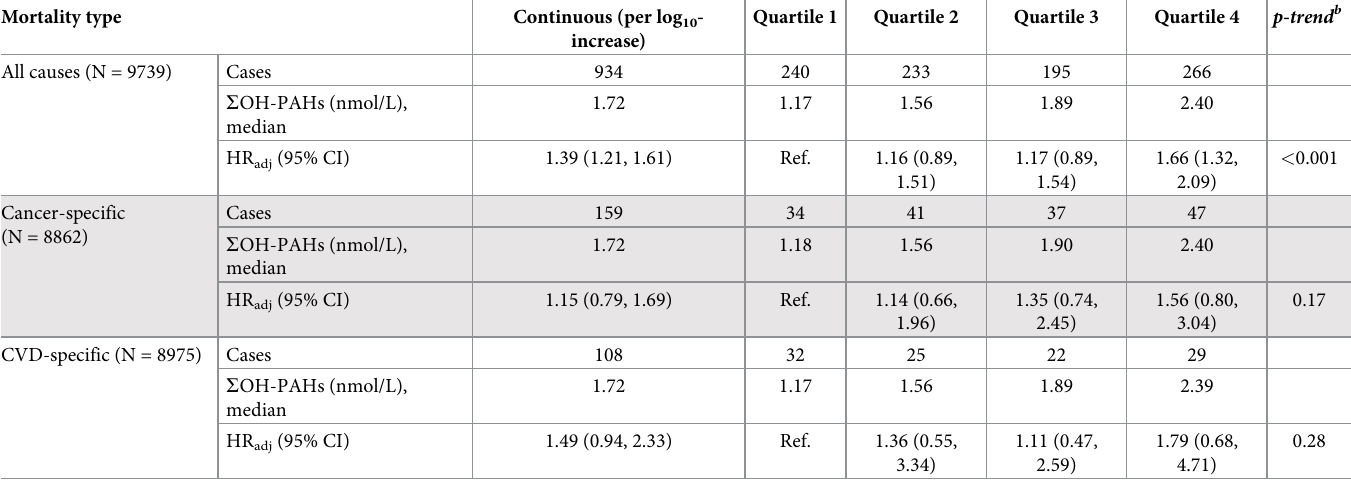
Abbreviations: CVD = cardiovascular disease a Models adjusted for age (years), gender (male/female), race/ethnicity (non-Hispanic white, non-Hispanic black, Hispanic, other race/ethnicity), smoking status (current, not-current), BMI (kg/m 2 ), survey cycle (cycles 1–7), educational attainment ( < high school, high school graduate, some college or above), family poverty status (above, at or below family poverty threshold), and urinary creatinine (g/L) b Computed using a ’continuous’ exposure created out of medians of each quartile of log 10 S